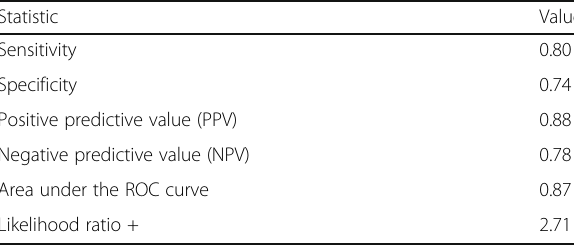
Table 4 The Results of ROC